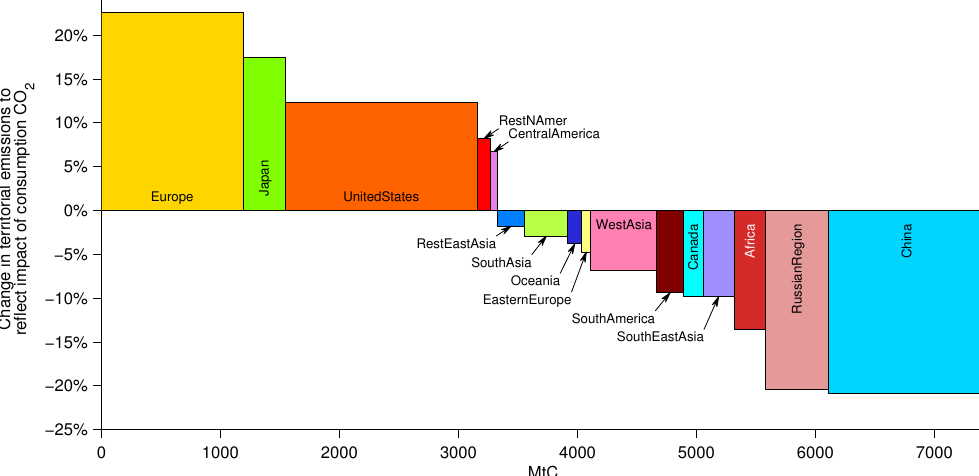
Fig. 6. The change in production-based CO 2 emissions when adjusted to a consumption basis (2004). The horizontal axis shows production emissions, while the vertical axis shows the relative change. This figure disaggregates key regions from the RECCAP region set. In particular, this highlights the significant difference between Japan and China, both in the East Asia